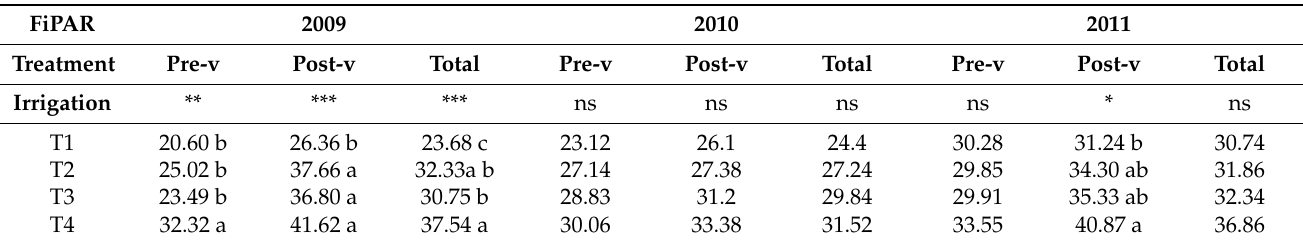
Table 4. Fraction of interception of PAR radiation (FiPAR) in % (average values per period) of the irrigation management treatments at high load in pre-veraison (Pre-v), post-veraison (Post-v), and throughout the period (Total), in the years 2009, 2010, and 2011.